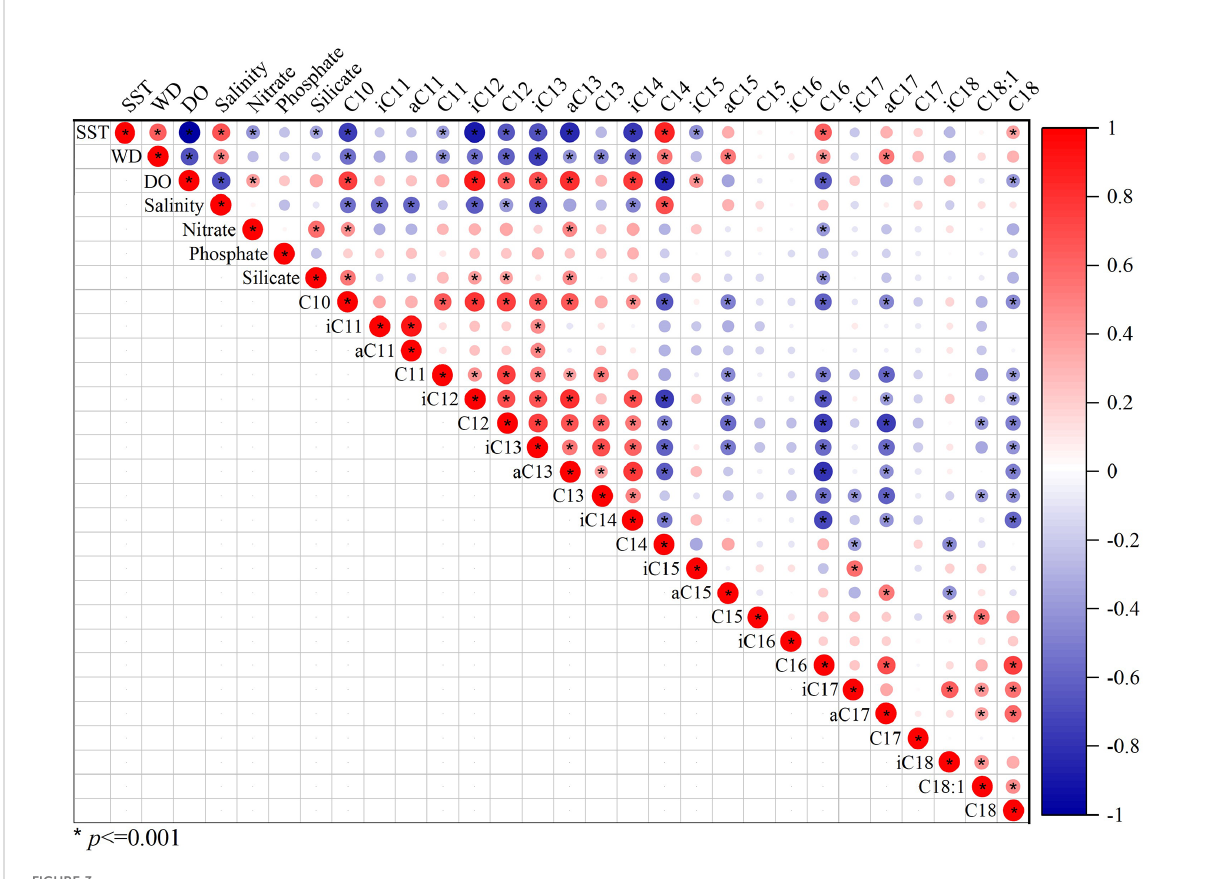
FIGURE 3 Hot map showing signi fi cant ( p < 0.001) Pearson ’ s correlation coef fi cients (circles) among the environmental parameters and fractional abundance of 3-OH-FAs (n =